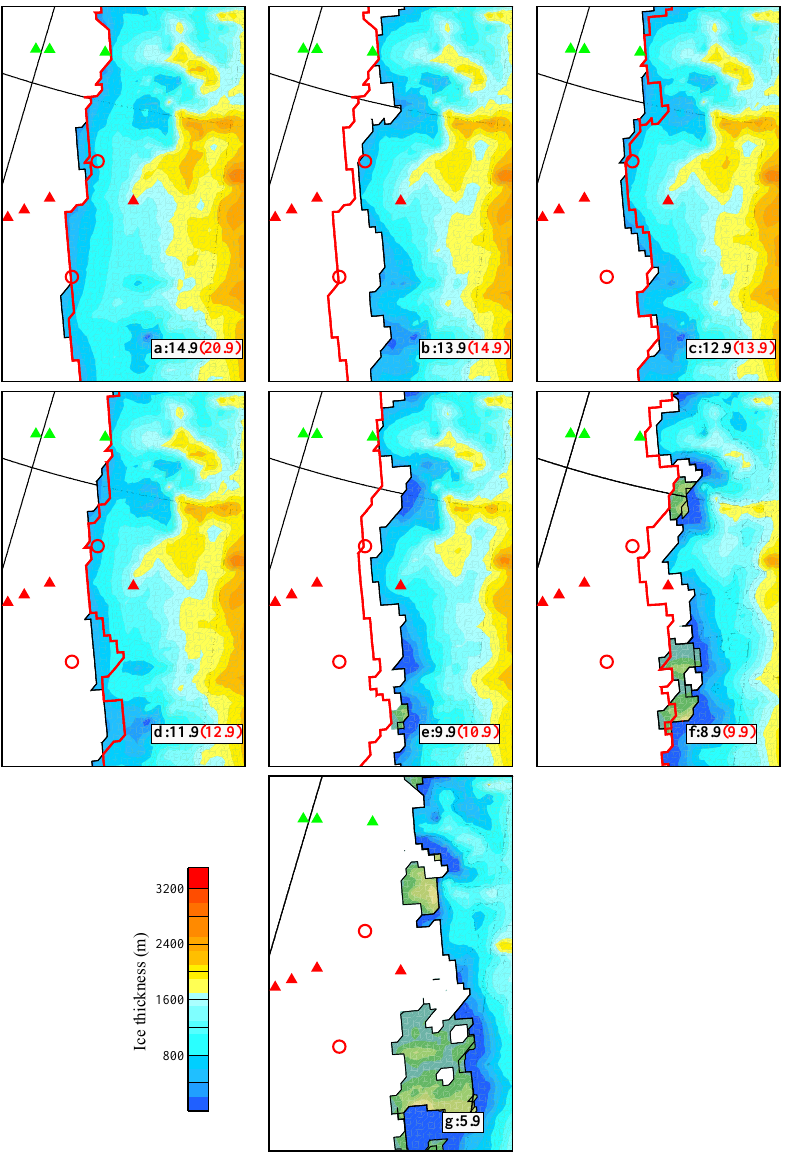
Figure 7. Retreat of the grounded ice sheet along the SW margin (region bounded by the red box in Fig. 1) for Av A s + AvSSM1 (ka BP). The red contour marks the edge of the grounded ice sheet at an earlier time step (given in red): (a) 14.9 (20.9), (b) 13.9 (14.9), (c) 12.9 (13.9), (d) 11.9 (12.9), (e) 9.9 (10.9), (f) 8.9 (9.9), and (g) 5.9. There is minimal change between the extent at 5.9 and the present day. Observed data constraining the timing of retreat are summarized in Table 1. Small floating ice shelves formed at the edge of the grounded ice sheet, but these are not